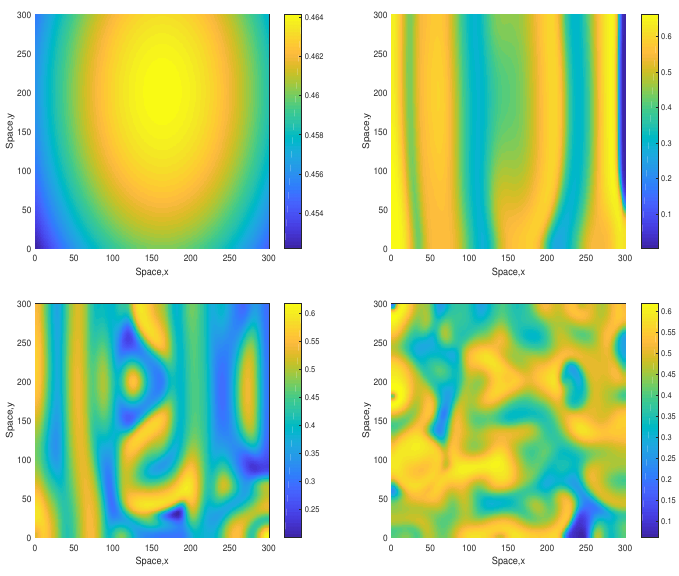
Figure 4. Spatial distribution of the oxygen concentration obtained for A = 2.06 and shown for t = 1, t = 300, t = 500 and t = 900 (left to right, top to bottom). Other parameters are the same as above. The initial conditions are given by Equations (13)–(15) with c 0 = 0.4630, u 0 = 0.4245 and v 0 = 0.1314. However, for a larger value of A the patterns become different showing the same tendency as above, i.e., they become more regular and exhibit a clear spiral structure. A typical example is shown in Figure 5 obtained for A = 2.4. Similar dynamics are observed for some larger values of A , e.g., see Figure 6 obtained for A = 2.7 and the same initial conditions given by Equations (13)–(15).